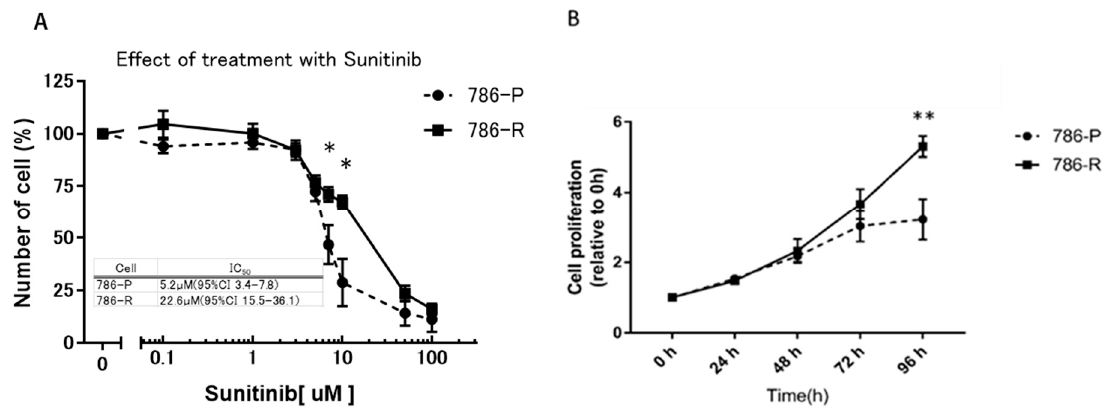
Figure 1. Cellular profile of established 786-R cells in vitro: ( A ) Effect of sunitinib treatment between 786-P and 786-R cells in vitro. Sunitinib-resistant cell line 786-O (786-R) and the parental cell line 786-O (786-P) were treated with sunitinib at indicated concentrations. Data are shown as mean ± standard error of the mean. * p < 0.05, ** p < 0.01. ( B ) Cell proliferation under sunitinib exposure. Significant enhancement of 786-R cell proliferation was observed at 96 h after sunitinib (5 µM) exposure compared with that in 786-P cells. All experiments were repeated in triplicate in three independent experiments. Data are shown as mean ± standard deviation. Data were analyzed for statistical significance by the Mann–Whitney U test. * p < 0.05, ** p < 0.01.